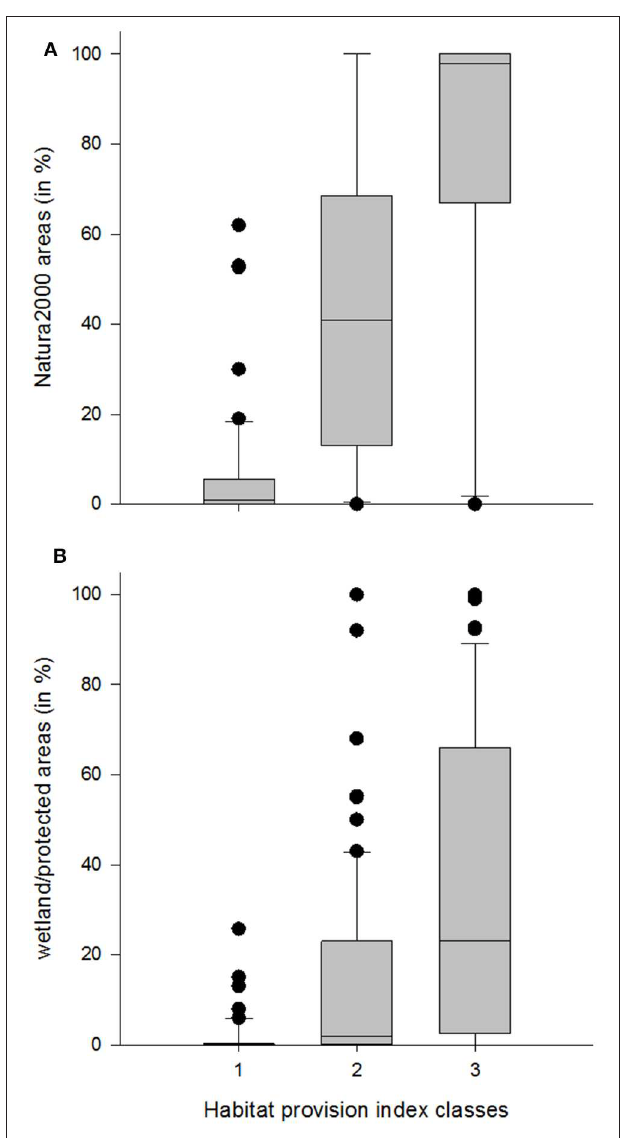
FIGURE 5 | Box and whisker plots of available proxies of high value floodplain habitats for the status quo for the habitat provision index classes (1 to 3) for the River Nahe and Hördter Rheinaue (River Rhine); boxplots showing median, range, and interquartile range of proxies (Natura2000 areas and wetland/protected area in %). (A) Percentage of biodiversity Natura2000 areas as an indicator for biodiversity, and (B) Percentage of wetland/protected area as an indicator of ecological intact floodplains. The only two values from the habitat provision class 4 of the Hördter Rheinaue were not included in the analysis. Superscript letters indicate significant differences among the habitat provision index classes (Dunn’s test, p <